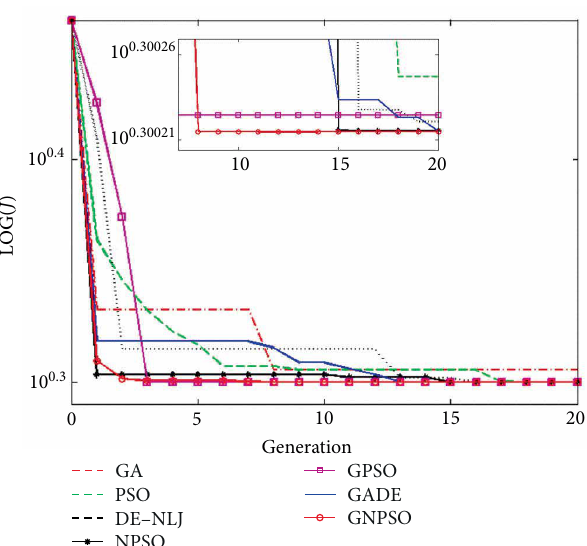
Figure 7: Comparison of convergence process of the GA, PSO, NPSO, GPSO, DE–NLJ, GADE and GNPSO for nonlinear wing vibration